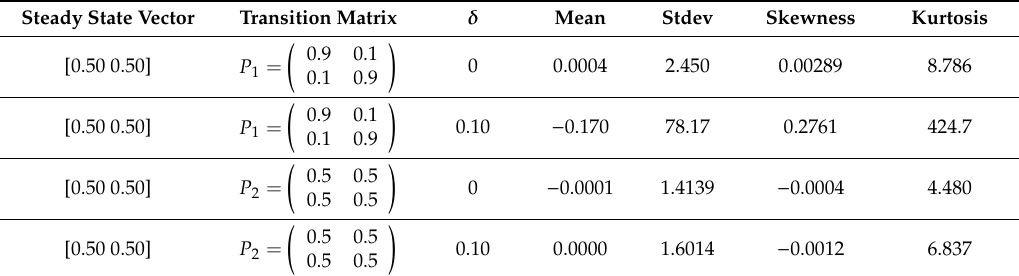
Table 1. Moments of TAR(1) with Markov-switching exogenous